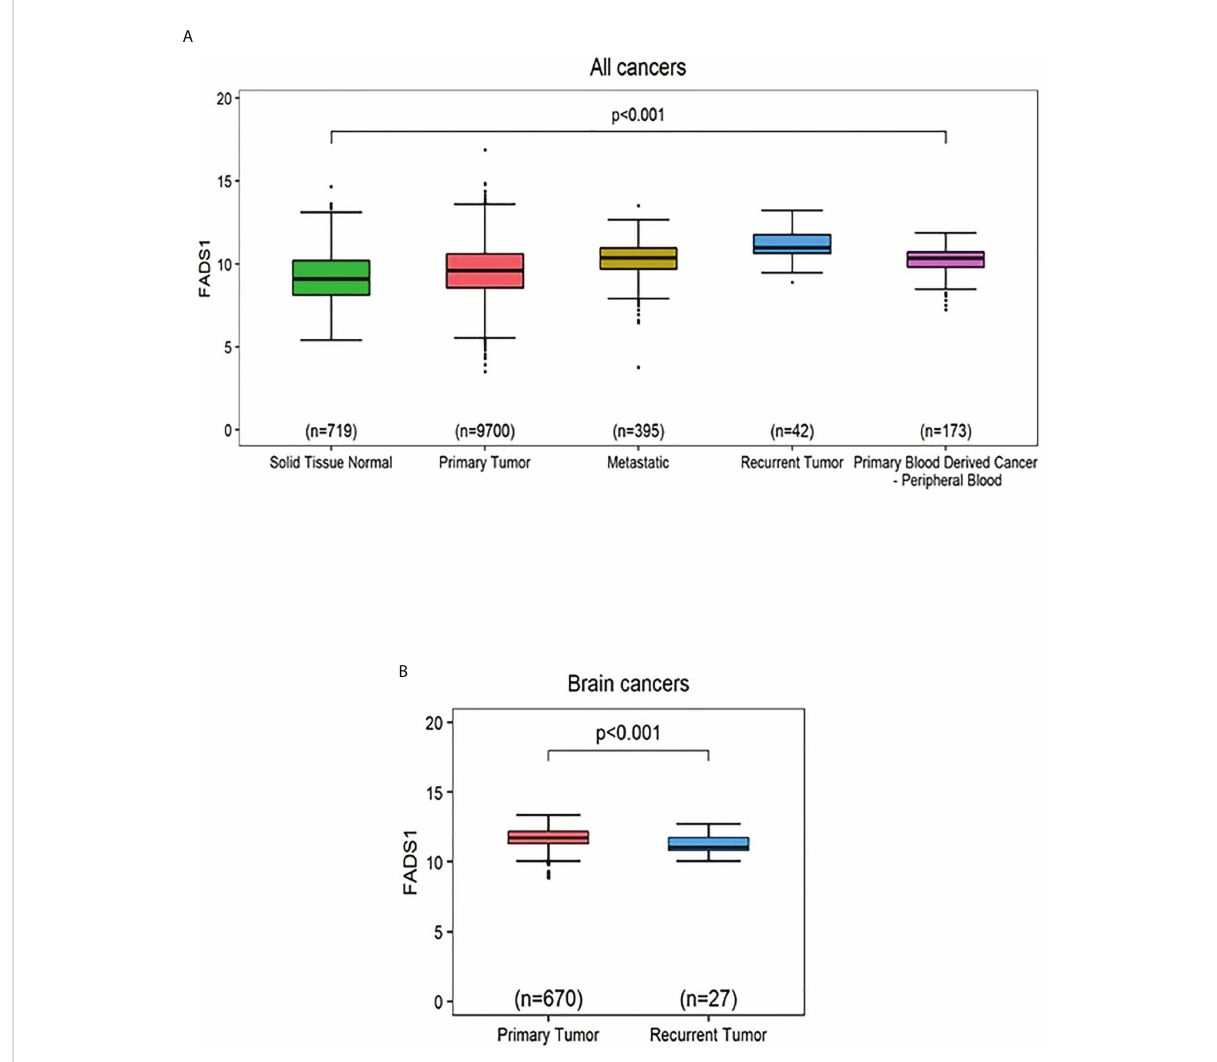
FIGURE 3 The mRNA expression levels of FADS1 according to sample type normalized by z-score. (A) In all cancer types. The median (interval of inter- quartile range [IQR]) is 9.09 (8.13,10.21), 9.58 (8.56,10.60), 10.36 (9.71,10.94), 10.98 (10.64,11.76), and 10.34 (9.81,10.71) for ‘ Solid Tissue Normal ’ , ‘ Primary Tumor ’ , ‘ Metastatic ’ , Recurrent Tumor ’ , and ‘ Primary Blood Derived Cancer - Peripheral Blood ’ , respectively. The p-value was obtained by Kruskal-Wallis test. All post-hoc p values for pairwise comparisons were less than 0.001 except for the pairwise comparison between ‘ Metastatic ’ and ‘ Primary Blood Derived Cancer - Peripheral Blood ’ (Wilcoxon post-hoc p=0.184). (B) In brain cancer types. The p-value was obtained from a Wilcoxon-rank sum test. The median (IQR) is 11.75 (11.31,12.20) and 11.07 (10.82,11.75) for ‘ Primary Tumor ’ and ‘ Recurrent Tumor ’ ,